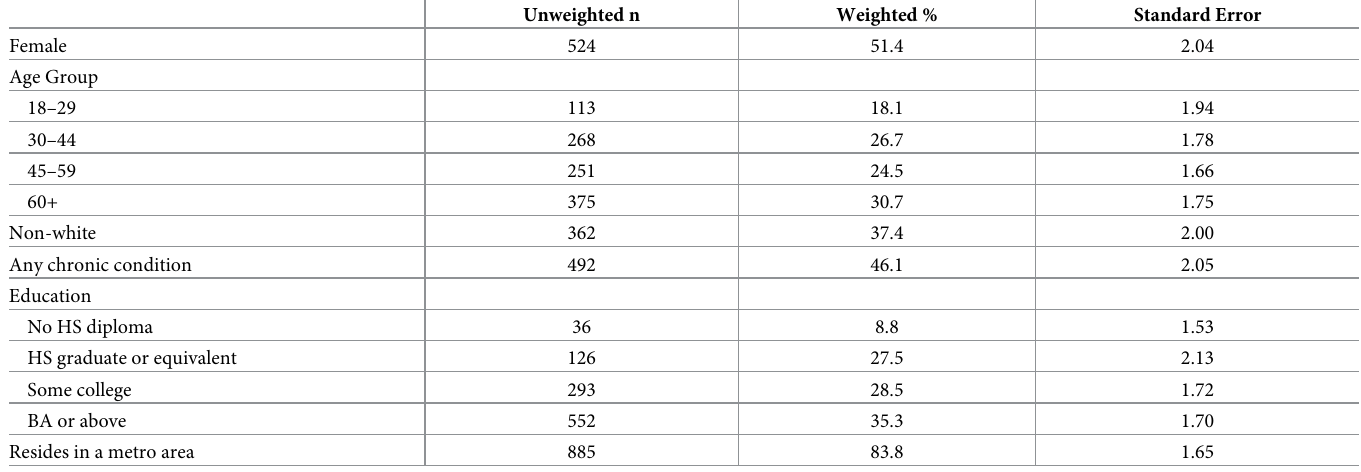
Table 1. Demographics of study